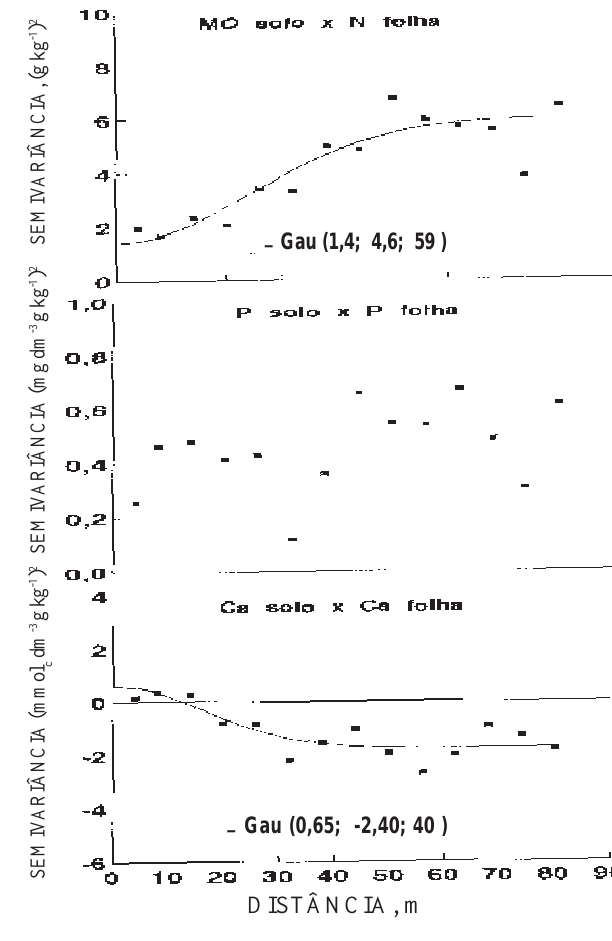
Figura 2. Semivariogramas cruzados entre matéria orgânica, P e Ca no solo e, respectivamente, N, P e Ca na folha, na avaliação da variabilidade em um pomar cítrico sob manejo uniforme, em Governa- dor Mangabeira (BA). As legendas incluem o mo- delo ajustado aos dados (Sph = modelo esférico e/ ou Exp = modelo exponencial e/ou Gau = modelo gaussiano) e, entre parênteses, os parâmetros C 0 , C 1 e alcance da dependência espacial; C 0 + C 1 re- presentam o patamar do